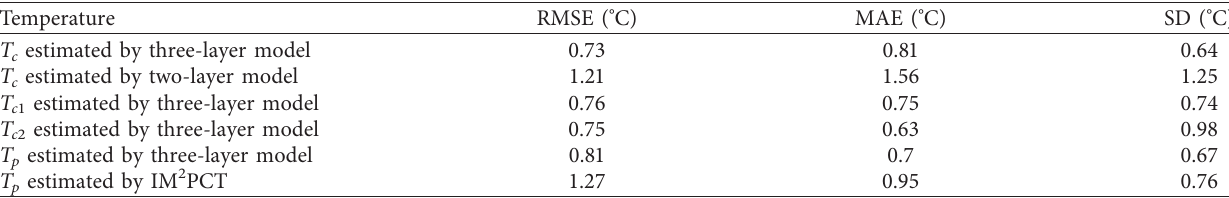
Table 6: Error analysis statistics of the comparison between measured and calculated canopy and panicle temperatures by models. Temperature RMSE ( ° C) MAE ( ° C) SD ( ° C) T c estimated by three-layer model 0.73 0.81 0.64 T c estimated by two-layer model 1.21 1.56 1.25 T c 1 estimated by three-layer model 0.76 T c 2 estimated by three-layer model 0.75 T p estimated by three-layer